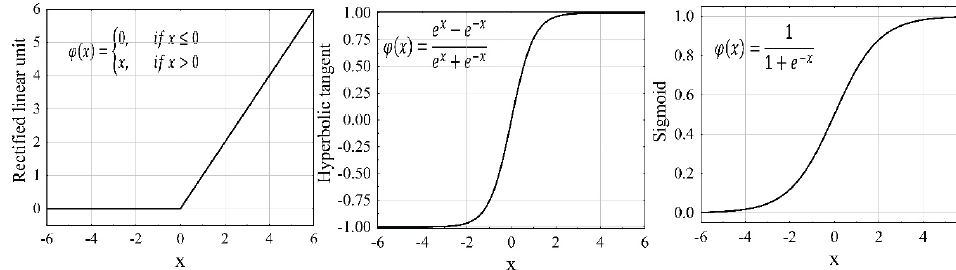
Figure 9. The most well-known activation functions.